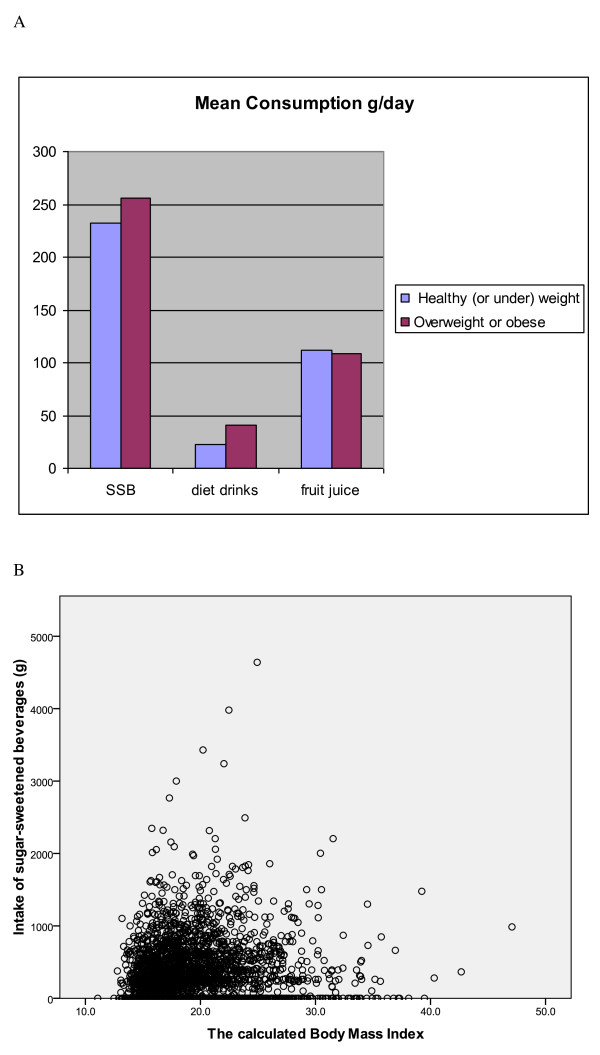
(a) Mean consumption of beverages across all children (consumers and non consumers). (b) Consumption of SSB across all children plotted against BMI.